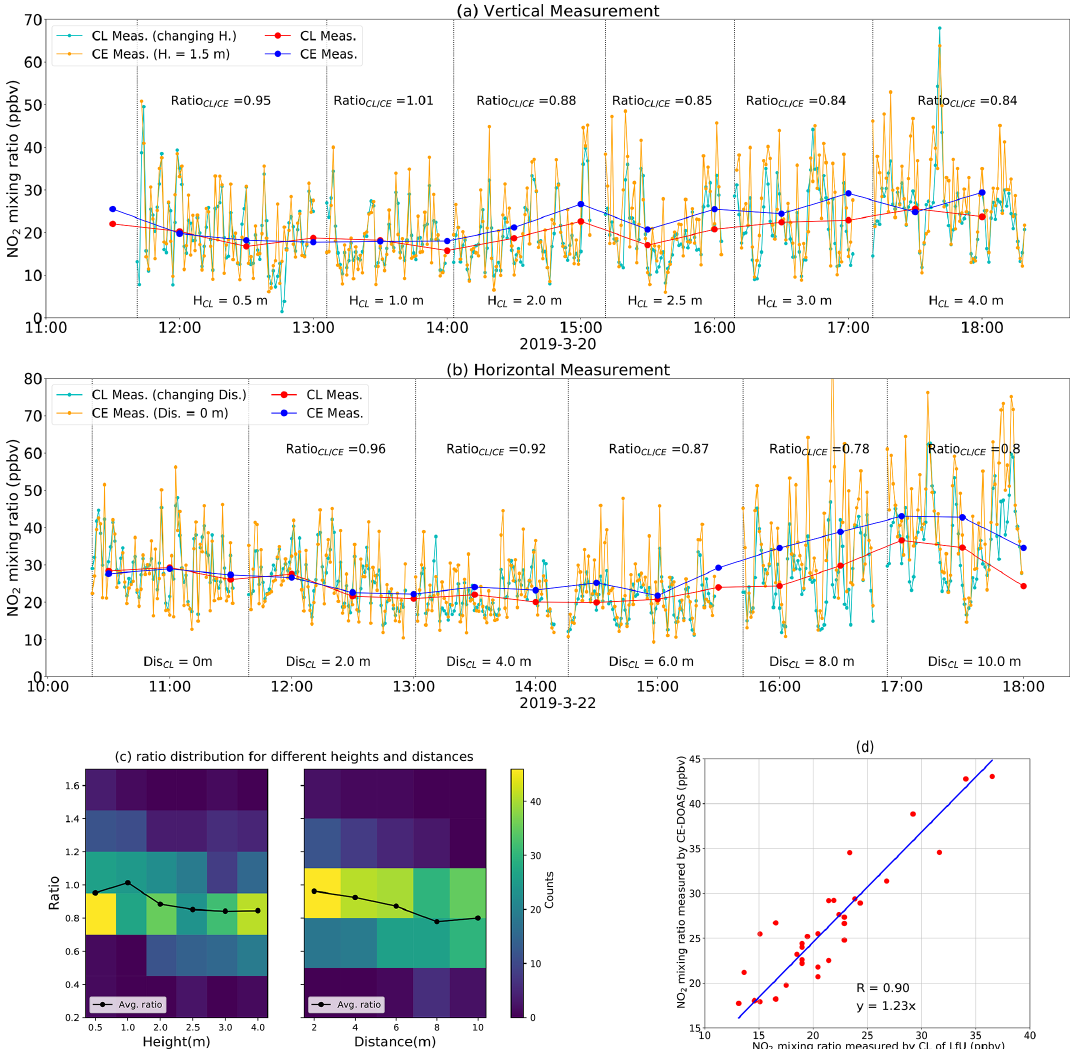
Figure 5. NO 2 measurements at Karlsplatz (Stachus), Munich, with different heights above ground (a) and distances to the main street (b) . The ratio between 1min averaged CE DOAS and coinciding CL measurements were calculated individually for the different heights and distances. Half-hour averaged CE DOAS measurements (blue curve) were compared with the corresponding CL measurements (red curve). Averaged ratios for different heights and distances (as defined in panel a ) are shown in panel (c) ; CE DOAS measurements at 1.5m were averaged to 30min intervals and compared with the half-hourly data of the governmental monitoring station at 4m shown in panel (d)